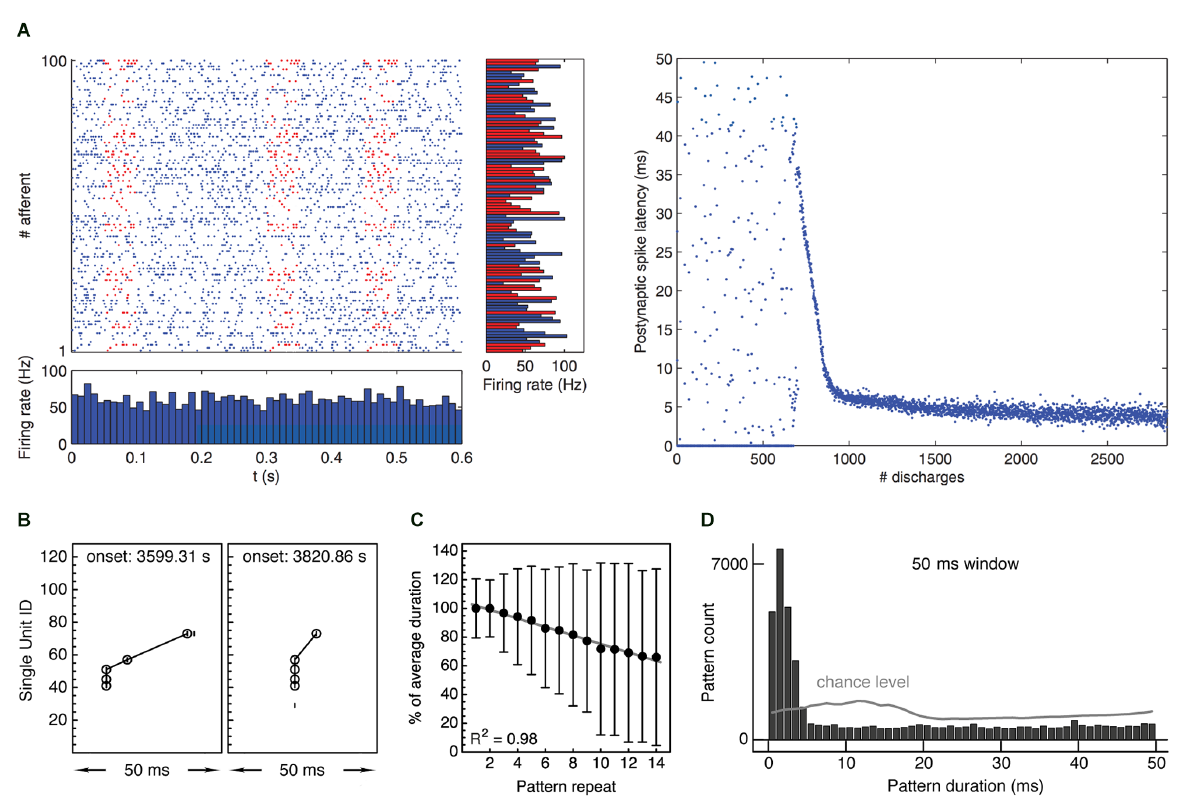
FIGURE3 Experimental evidence supporting the “synchrony through synaptic plasticity” hypothesis. (A) Left: Simulation showing 100 afferent inputs to a model neuron equipped with STDP. Half of the input spike trains contain a repeating spatiotemporal activity pattern lasting about 50 ms. Right: After an initial unselective period, the receiving neuron learns to selectively respond to the repeating pattern, gradually reducing response latency with respect to pattern onset from about 35 ms to about 5 ms, thus “tracking back” through the pattern and becoming a fast and reliable pattern detector. Taken from Masquelier et al. (2008). (B) Two occurrences of an example spike pattern recorded from spontaneous multineuronal activity in rat visual cortex in vitro . The second occurrence shows a temporally compressed pattern with increasingly synchronized spikes. Reproduced from Gansel and Singer (2008). (C) Gradual temporal compression of repeating spike patterns recorded from multineuronal activity in rat visual cortex in vitro , comprising 90,751 individual patterns. The plot shows median ± median deviation of pattern duration depending on pattern repeat and linear regression with coefficient of determination R 2 = 0.98, indicating robust compression. Duration normalized with respect to mean duration per pattern. Reproduced from Gansel and Singer (2008). (D) Distribution of durations of repeating spike patterns recorded from multineuronal activity in rat visual cortex in vitro . Patterns were collected using a sliding window of 50 ms and statistically validated. Gray line indicates chance level obtained from randomized data. Pattern durations are evenly distributed over the entire time window used for the pattern search, with the exception of a prominent peak below 5 ms, indicating precisely synchronous firing. Taken from Gansel (2014). Panels (C) and (D) contain data recorded from 10 brain